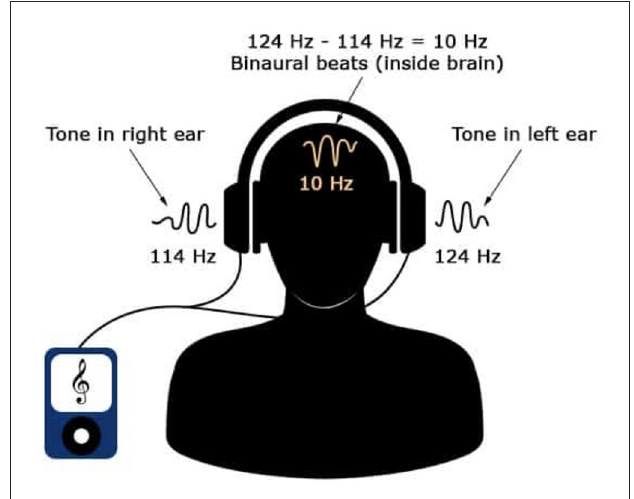
FIGURE1 Concept of Binaural beats. Image courtesy of Patrick Alban, DC and Deane Alban. https://bebrainfit.com/binaural-beats-meditation.